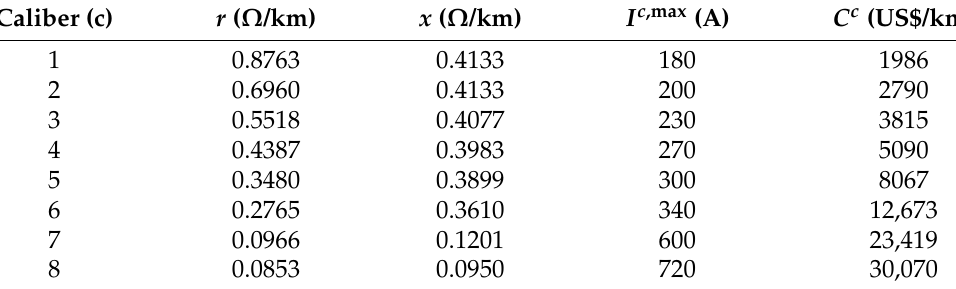
Table 11. Set of conductors considered in all the numerical